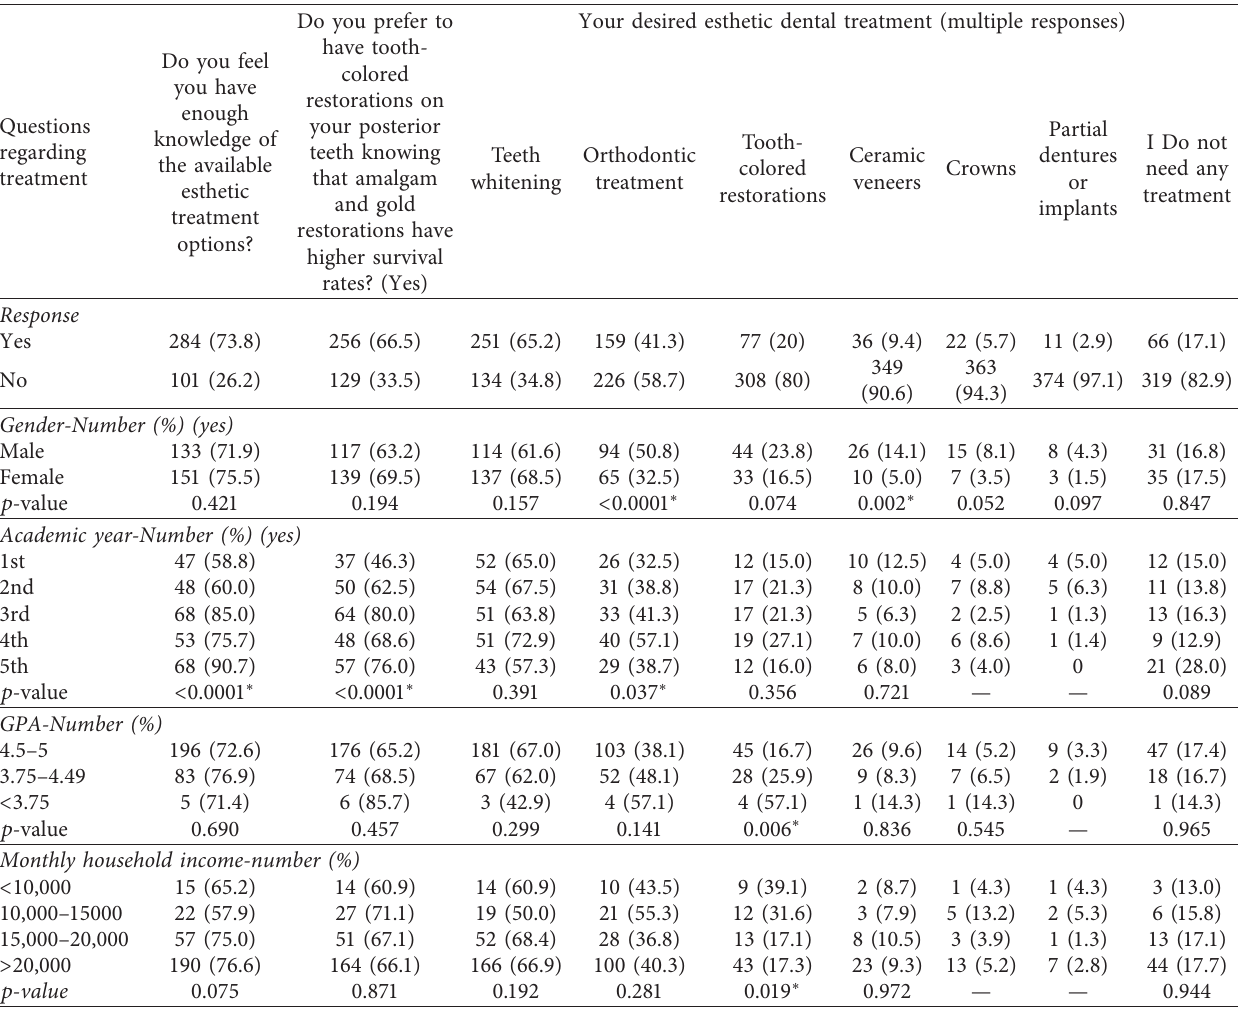
Table 4: Comparison of the subjects’ responses toward desired esthetic treatments with respect to their gender, academic year, GPA, and monthly household income (part